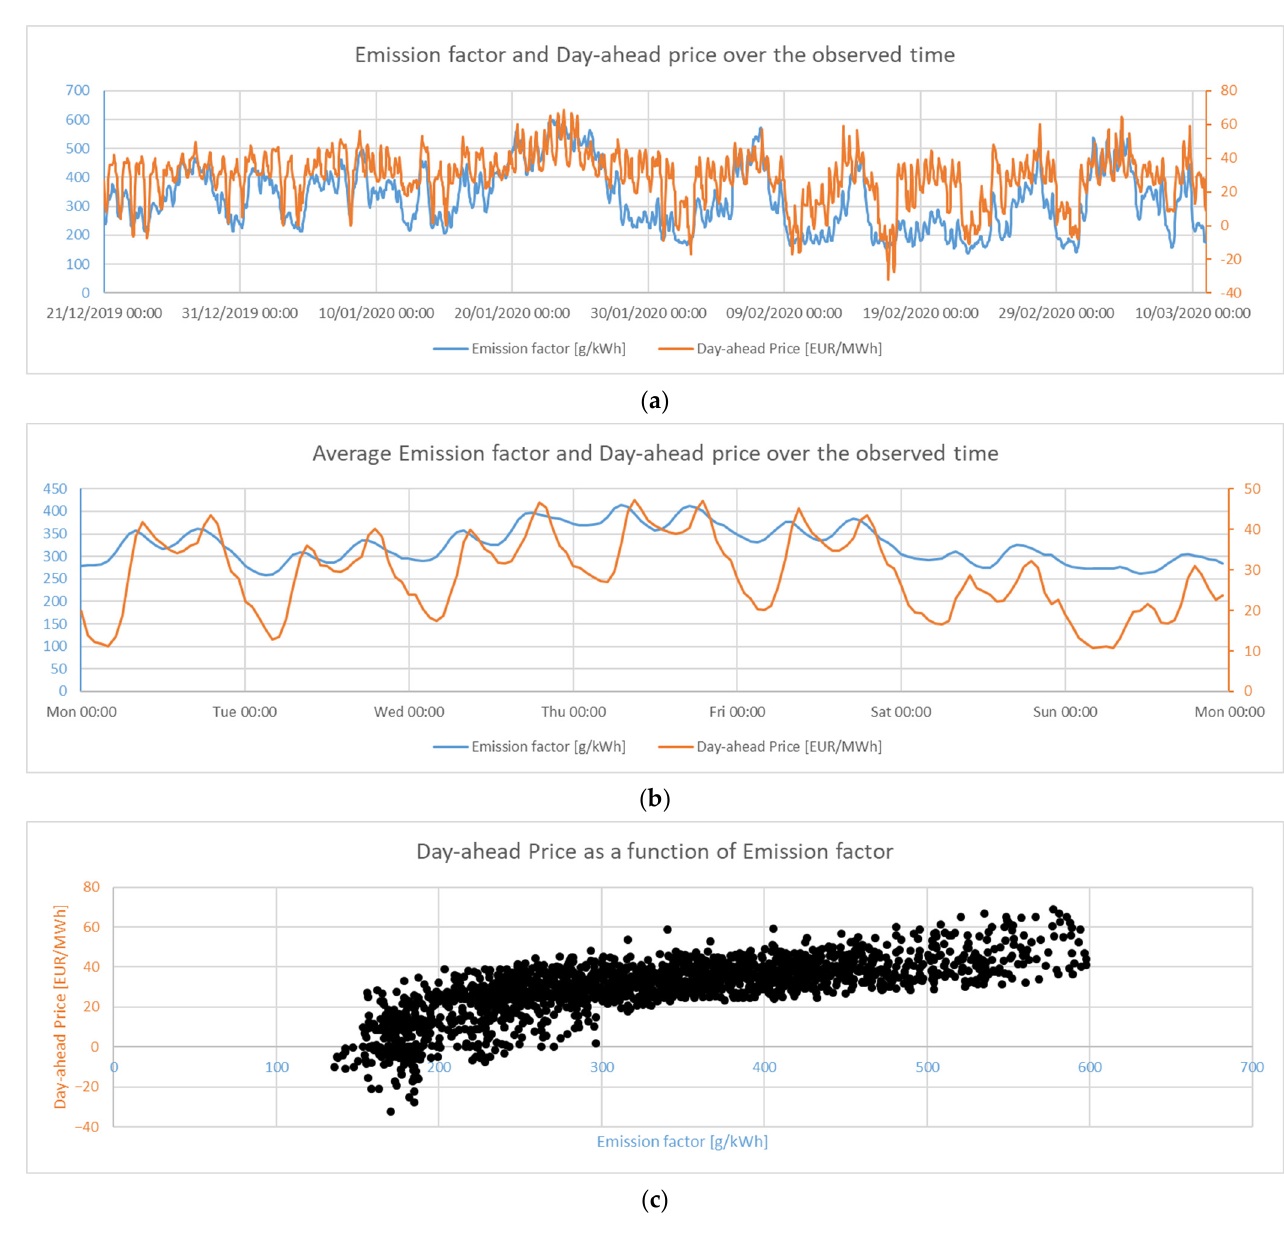
Figure 6. Emission factor [33] and day-ahead prices [32] used in this paper: ( a ) the full analysed period; ( b ) the average over a week; ( c ) the relationship between the two factors. In the scatter plot in ( c ), each dot reflects one hour, where the x - and y -axis values are defined by the mentioned prices and emission factors.